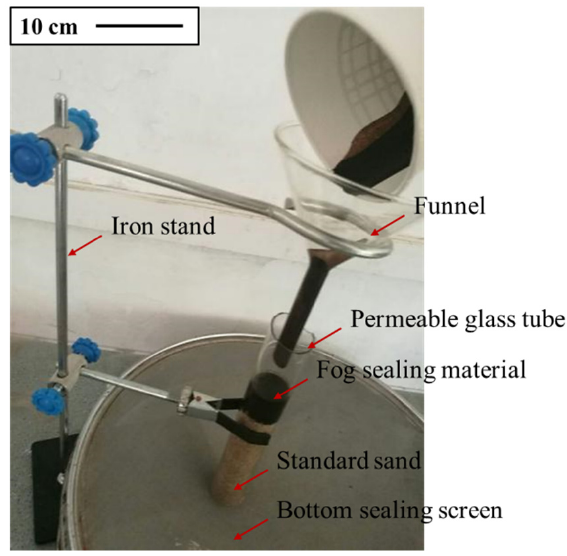
Figure 4. Improved penetration test device.